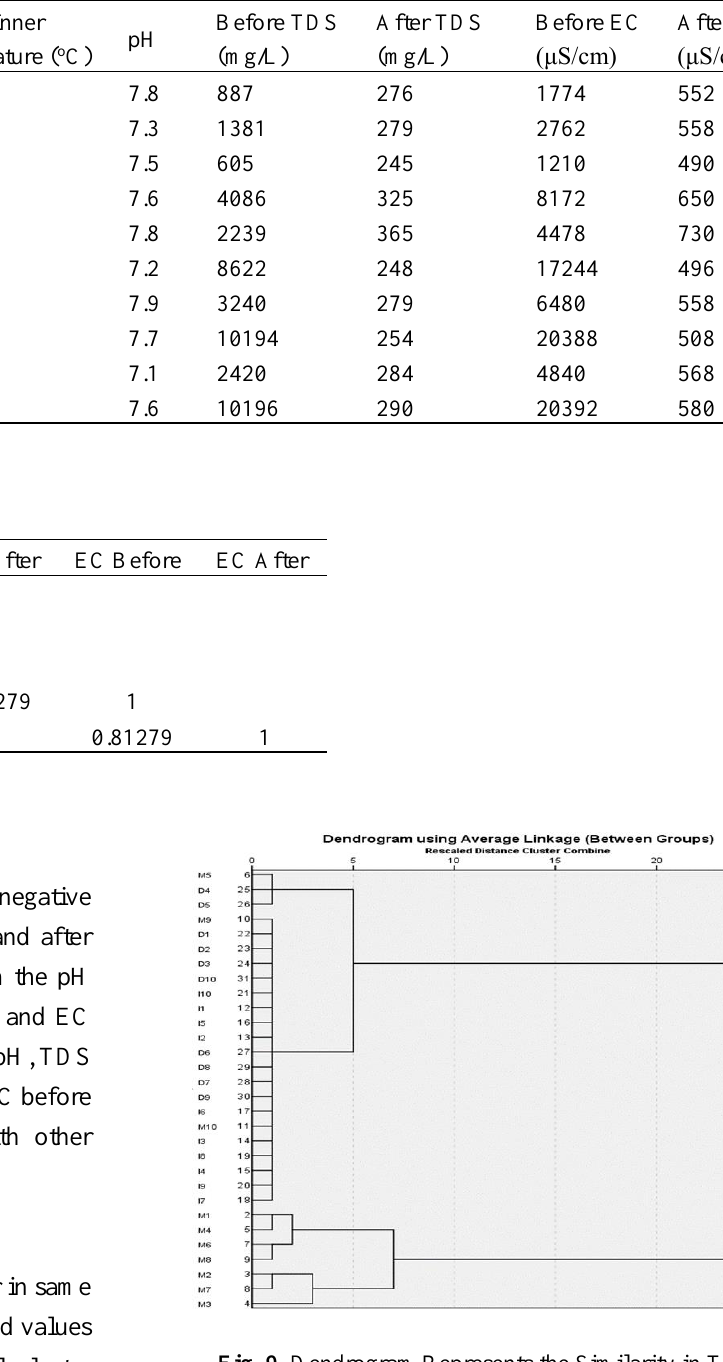
Fig. 9. Dendrogram Represents the Similarity in TDS Concentration Between Sampling